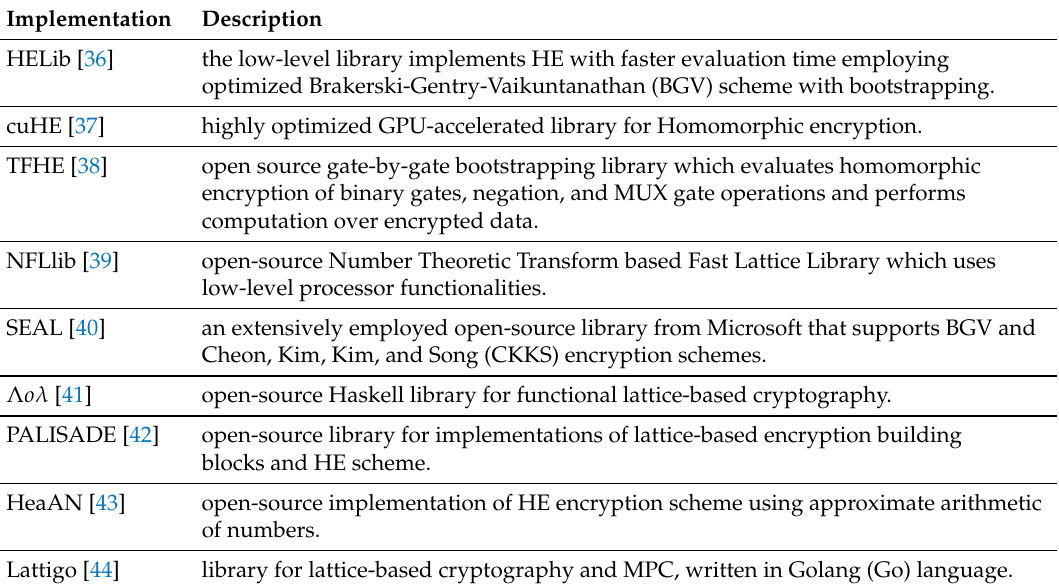
Table 1. Open-source implementations of